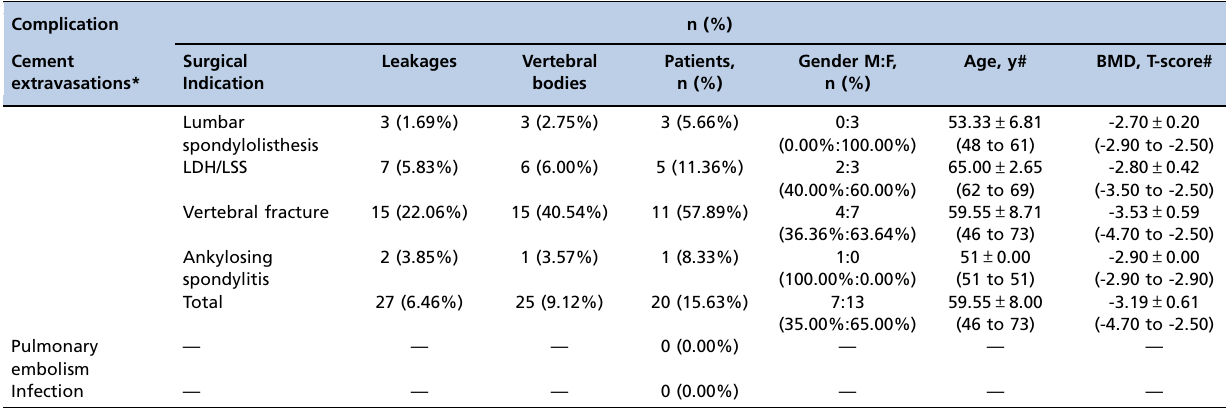
Table 3 - Complications in the 128 patients with PMMA-augmented CICPS.